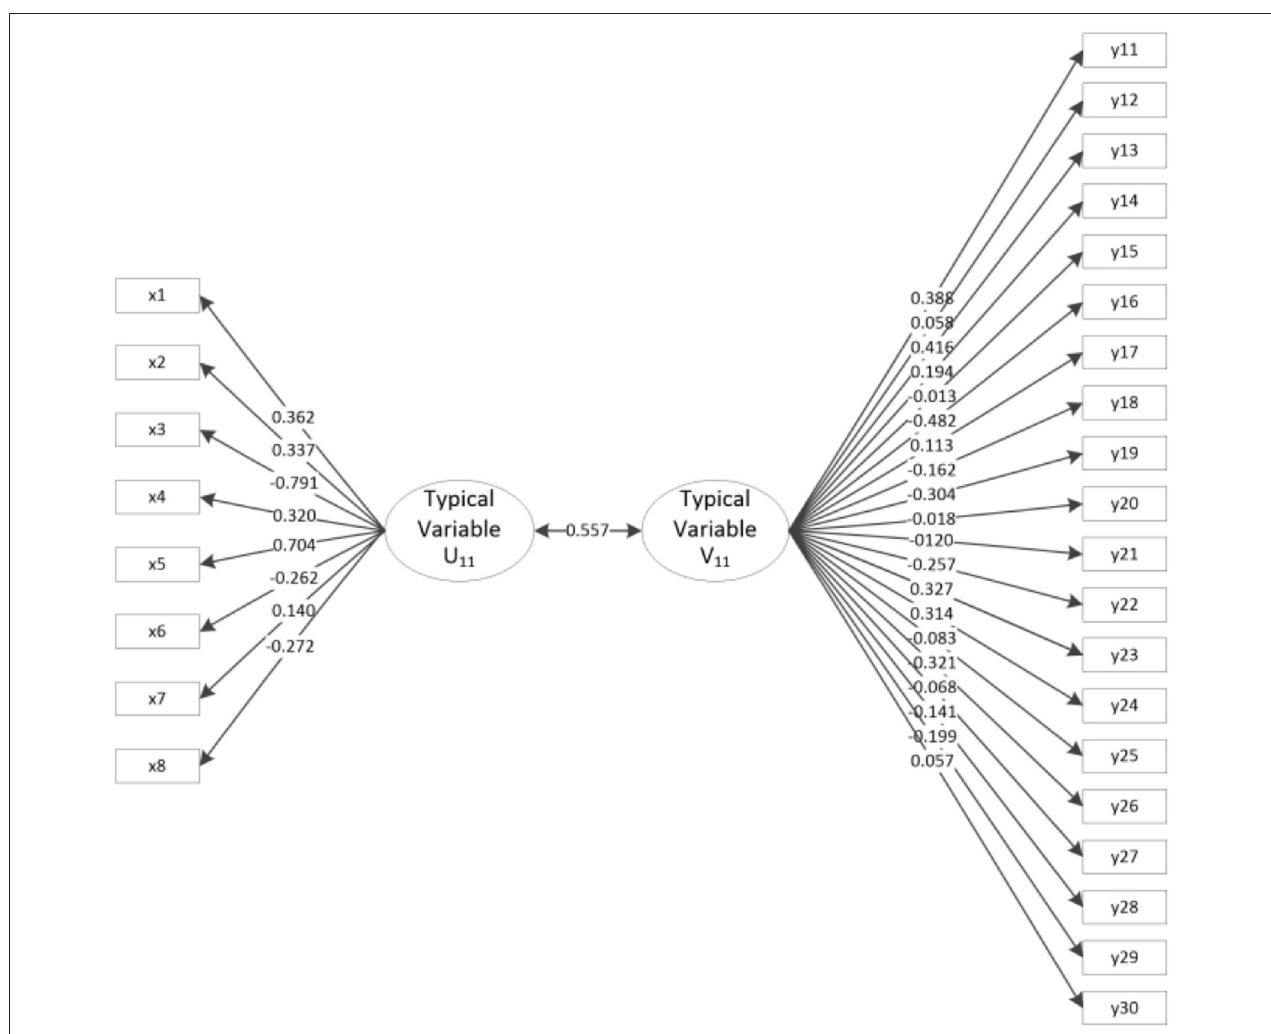
FIGURE 1 | Typical load coefficient and cross-load coefficient for motor performance and motor behavior.